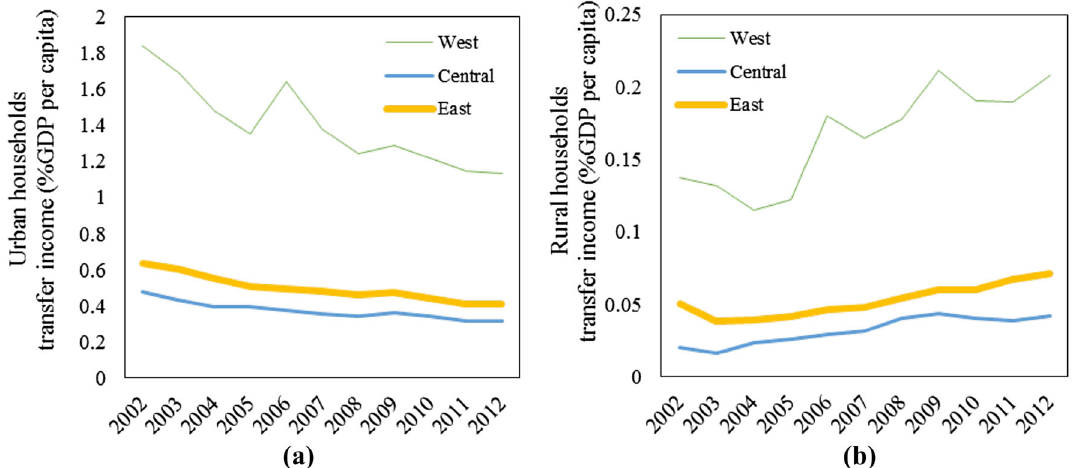
Fig. 2 Urban ( a ) and rural household ( b ) transfer income levels in the western, central, and eastern regions of China over the period from 2002 to 2012. Natural hazard-induced disasters caused